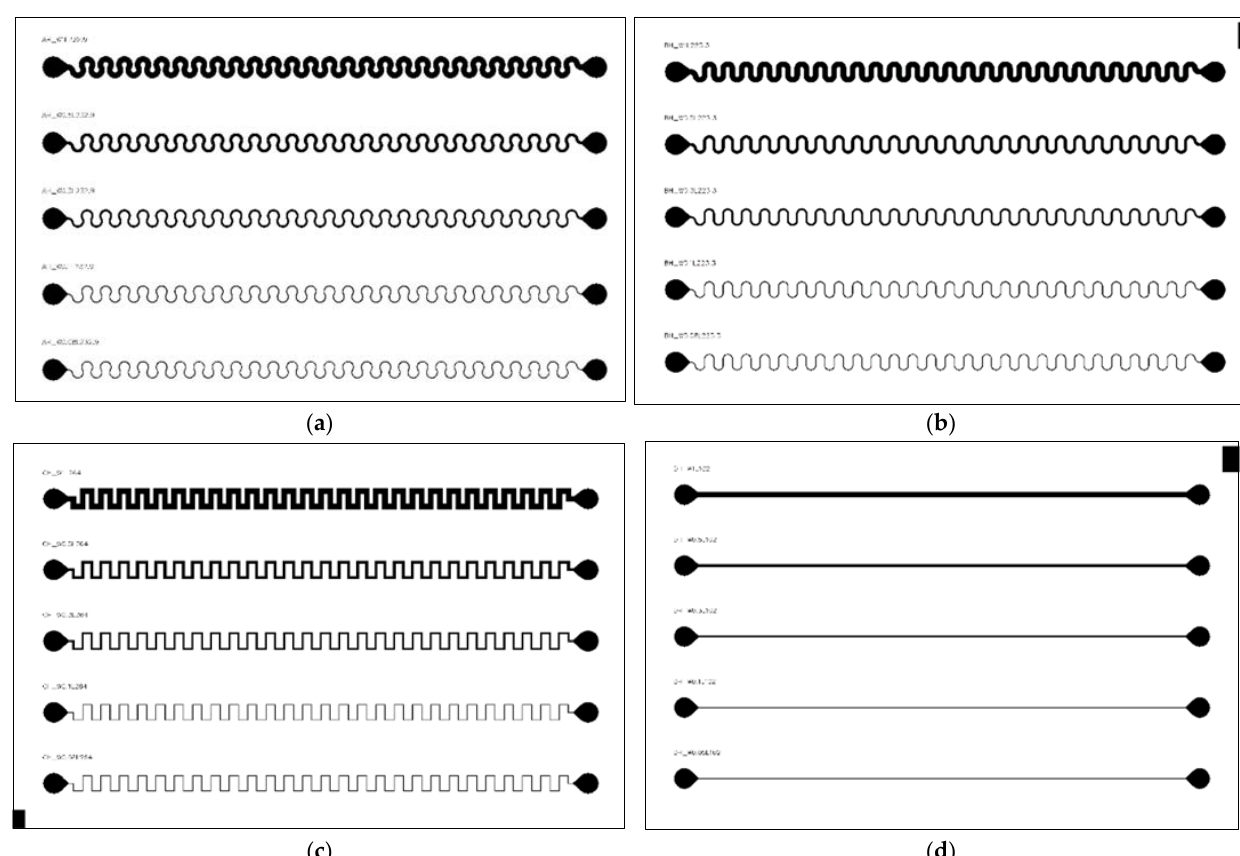
Figure 4. Cropped test sample with printing patterns ( a ) meander; ( b ) U-shape; ( c ) rectangular; ( d ) straight.